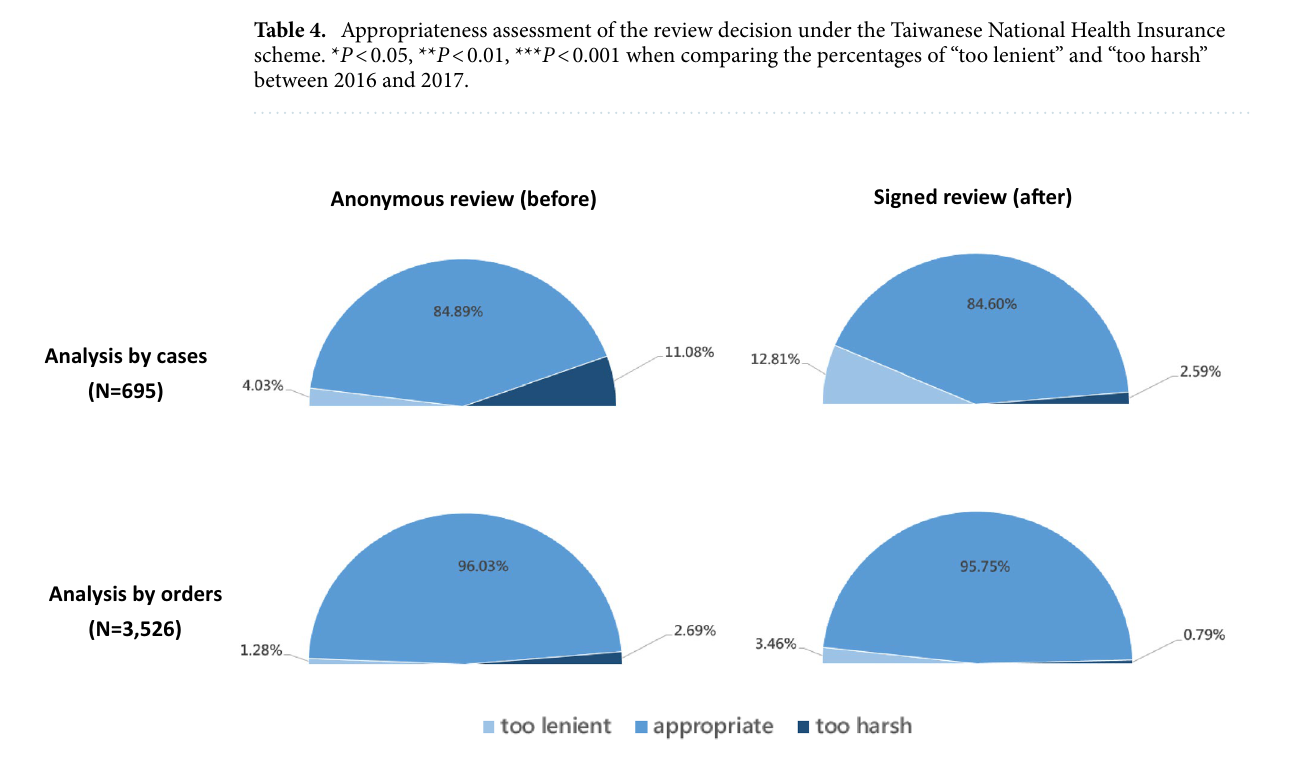
Figure 1. The distribution of inappropriate review decisions under anonymous and signed